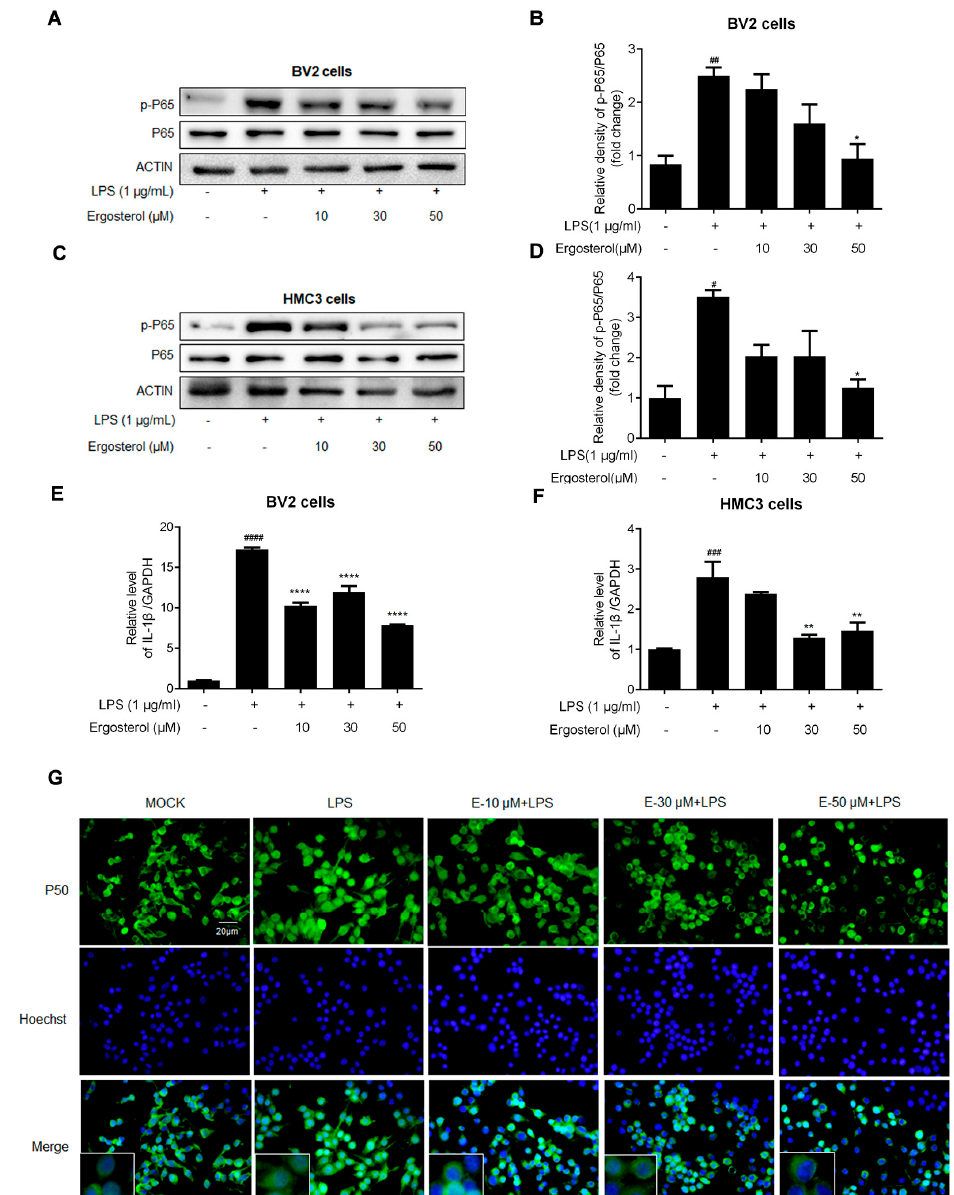
Figure 2. Ergosterol suppresses activation of the NF- κ B signaling pathway in BV2 and HMC3 cells stimulated by LPS. BV2 and HMC3 cells pretreated with Ergosterol for 2.5 h, then LPS stimulated